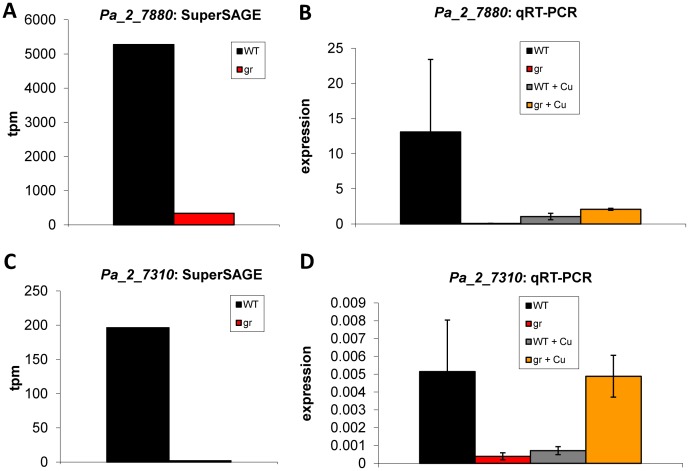
Transcript analysis of Pa_2_7880 (PaMth1: A, B) and Pa_2_7310 (C, D).The results of the SuperSAGE analysis (A, C) are shown as tags per million (tpm) for wild type (WT) and grisea (gr). The results of the qRT-PCR (B, D) are relative expression levels of the gene of the wild type (WT, n = 6) and of grisea (gr, n = 6) grown in standard medium, and wild type (WT+Cu, n = 3) and grisea (gr+Cu, n = 3) grown on copper supplemented medium, normalized to the expression level of the gene coding for mitochondrial PORIN. The error bars represent the standard deviation.